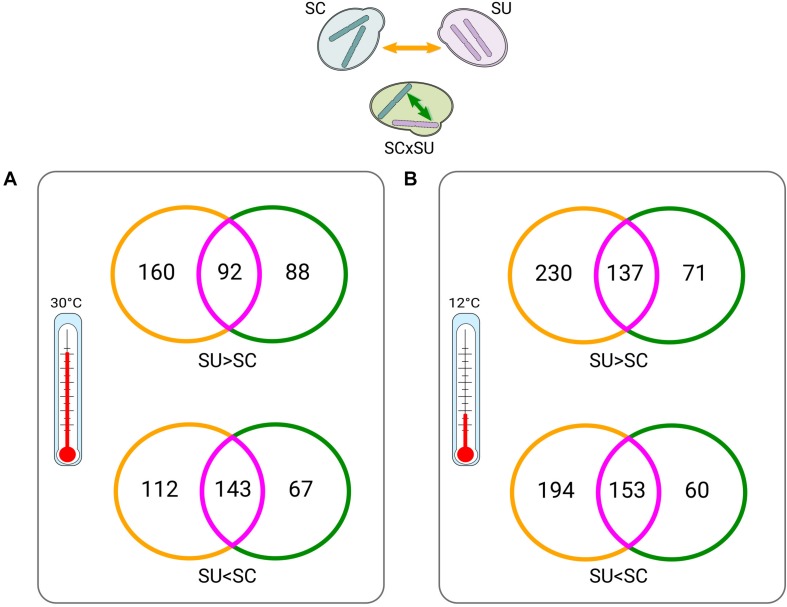
Venn diagrams of between-parent (yellow) versus within-hybrid (green) comparisons (depicted on the top) at 30°C (A) and at 12°C (B). Intersections (violet) indicate differentially expressed (DE) genes that appear in both conditions. Numbers indicate DE genes. Colors of the Venn diagrams correspond to the types of comparisons, as indicated by the arrows in the top scheme and consistent with Figure 1A (except for intersections). “>” and “<” symbols denote which homeologs or orthologs of a given species are expressed at significantly higher and lower levels, respectively (see Supplementary Tables 4, 5, 8, 9 for lists of the DE genes).